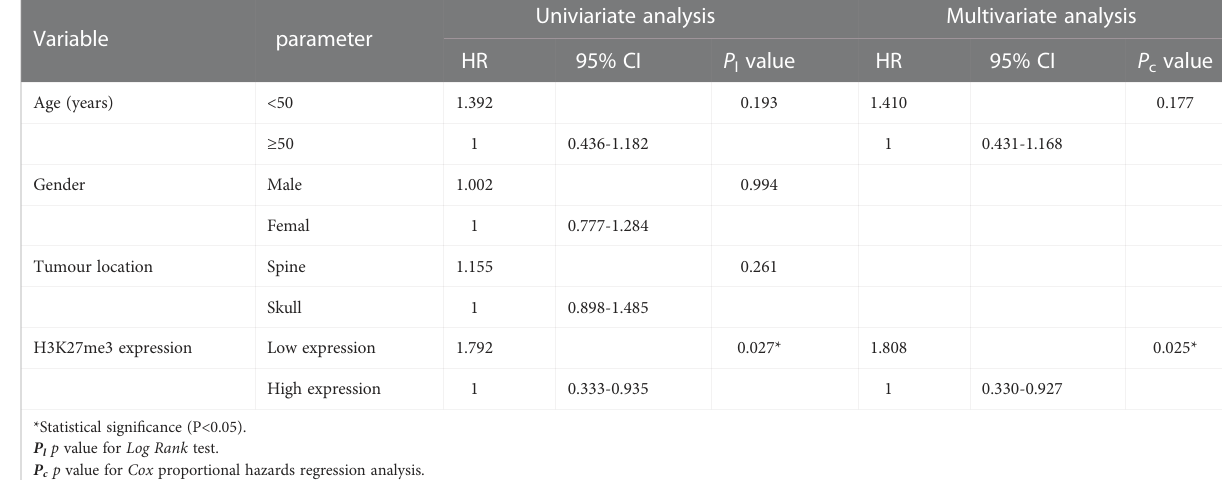
TABLE 3 Univariate and multivariate analysis of recurrence-free survival for chordoma patients.